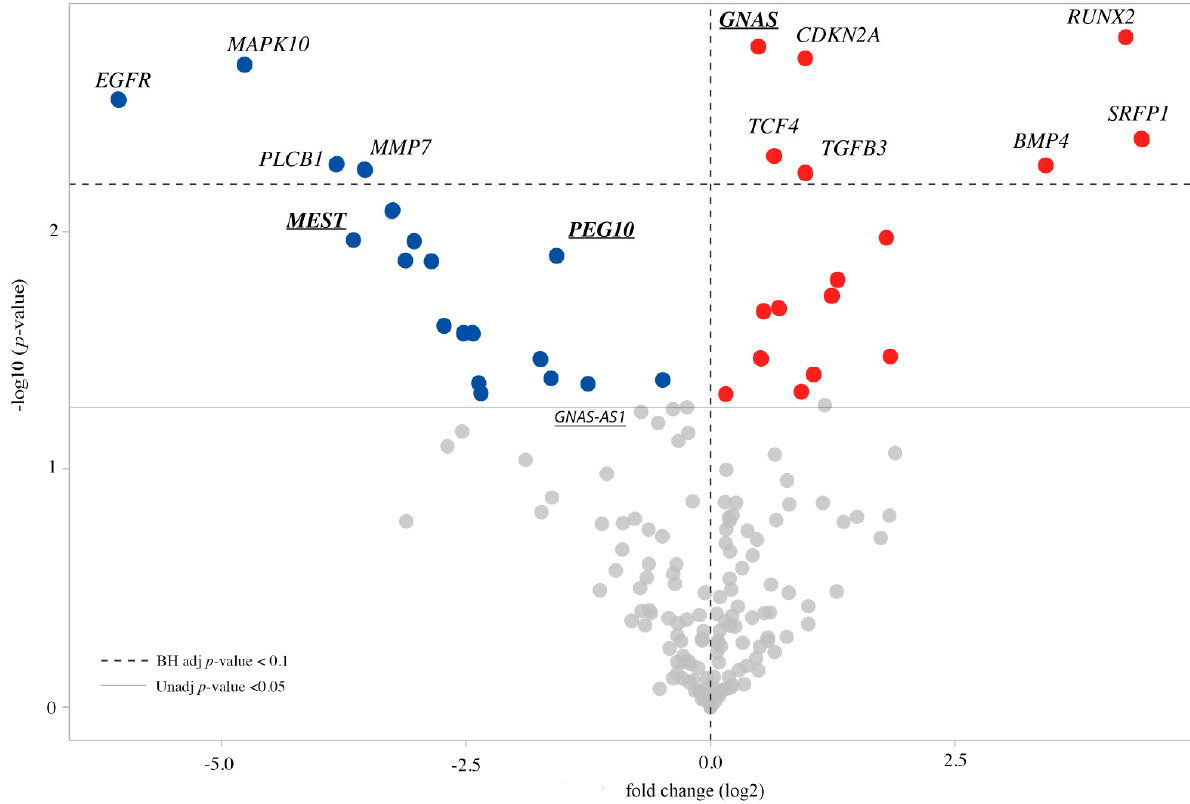
Figure 5. Volcano plot of DEGs CdLS compared to control cell lines. Upregulated genes are highlighted by red dots, while downregulated genes by blue dots. In bold and underlined are reported the DE imprinted genes. FDR < 0.1 (Benjamini– Hochberg adjusted p value) and unadjusted p value < 0.05 are indicated by horizontal lines. The VolcaNoser tool was used for creating volcano plots [51].